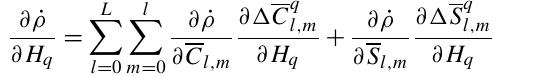
Figure 4. Definition of mascon surface elements in the Mississippi basin. The figure originates from Klosko et al. (2009), but it is con- verted to grey-scale for this